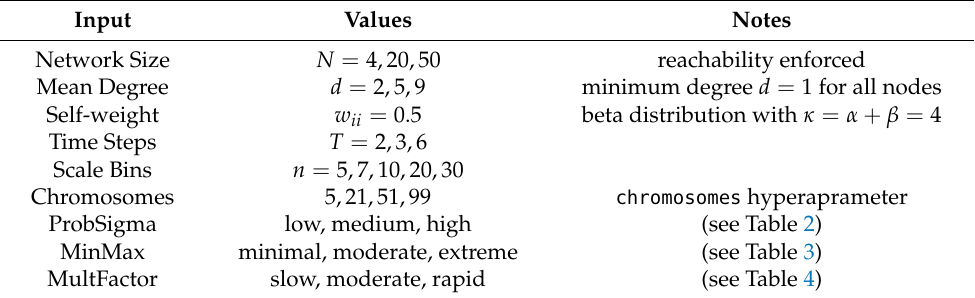
Table 5. Inputs used in the hyperparameters simulation